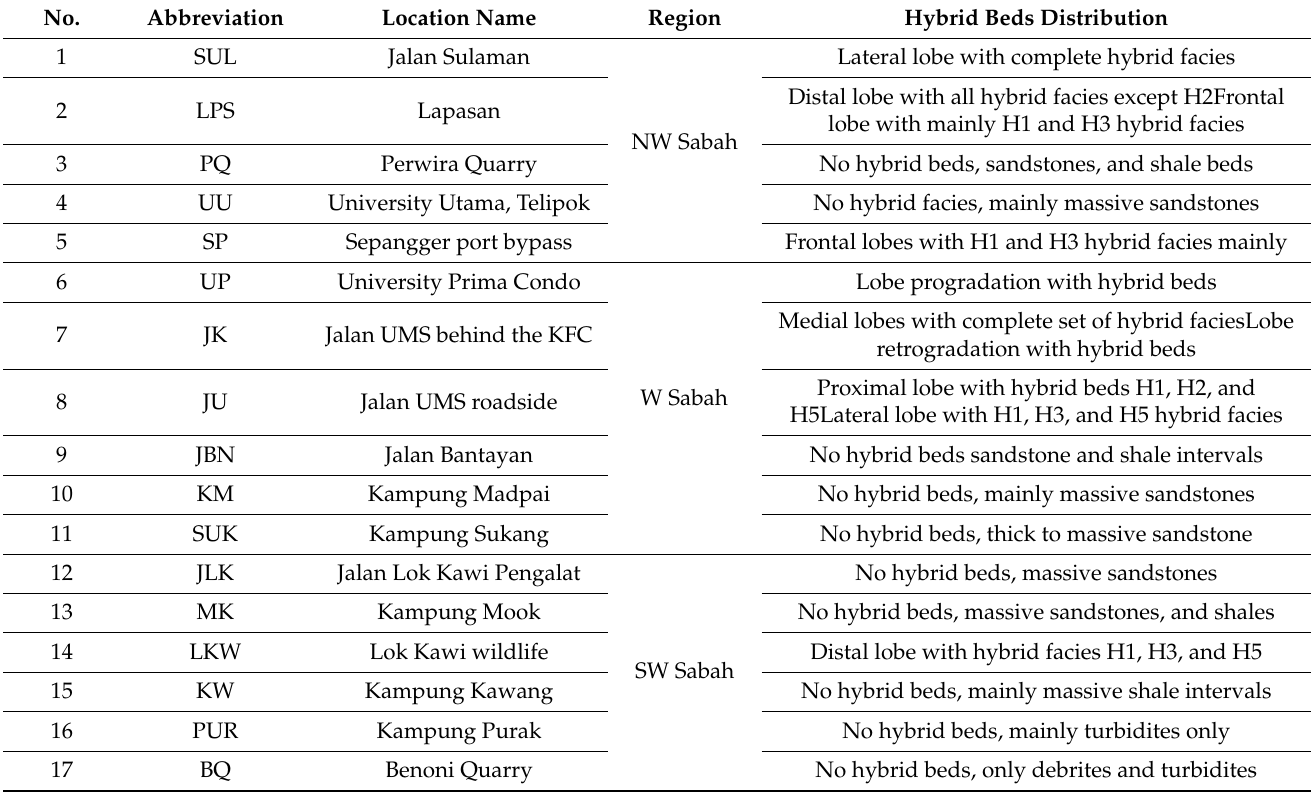
Table 1. Selected locations of onshore Sabah. Hybrid event beds are not commonly present throughout all outcrops. A summary of each section is presented in the table